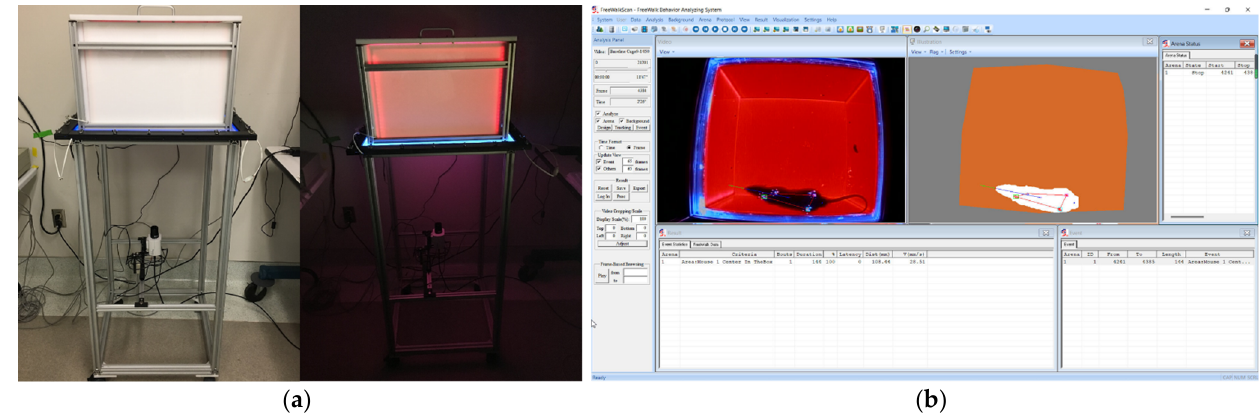
Figure 4. The devices and software used for gait analysis in this study: ( a ) Free Walk Box; ( b ) FreeWalkScan software.